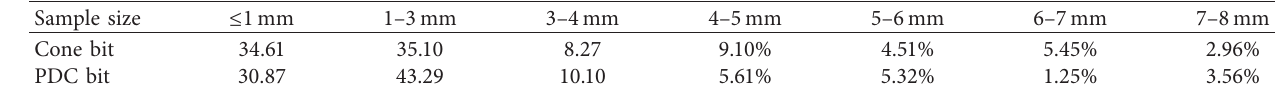
Figure 3: The process of coal sample preparation. Table 1: Particle size distribution of the original coal